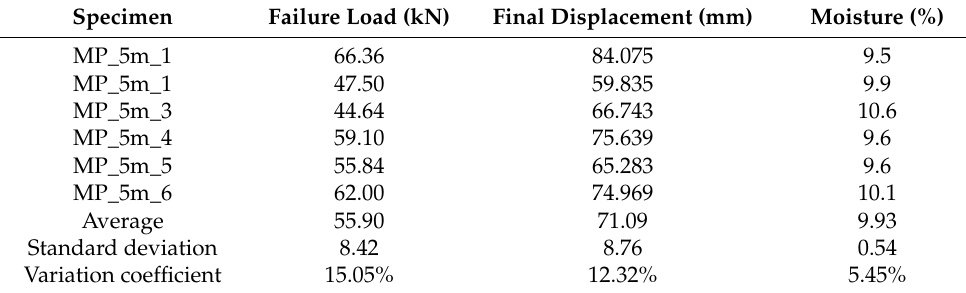
Table 1. Normal (non-perforated) samples—MP_5m results.